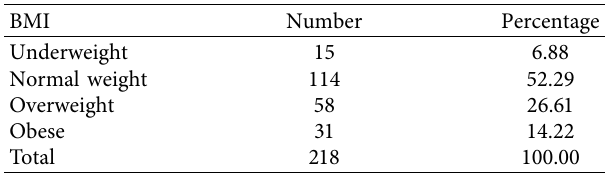
Figure 1: Liver contrast enhancement measurement: noncontrast image (a); portal venous phase image (b). Table 1: Distribution of patients by BMI.